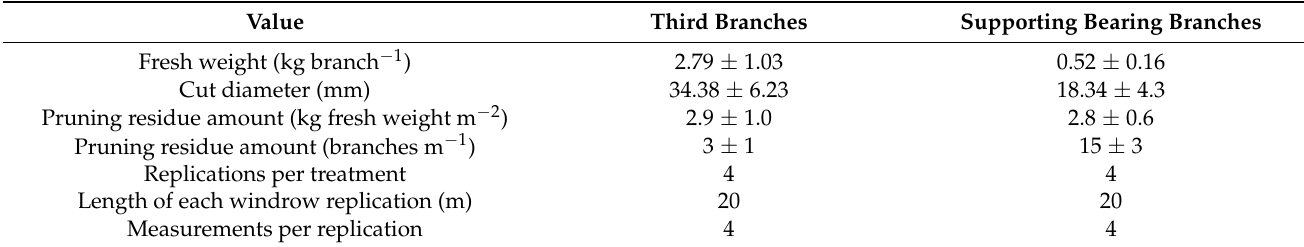
diameter, and pruning residue amount.